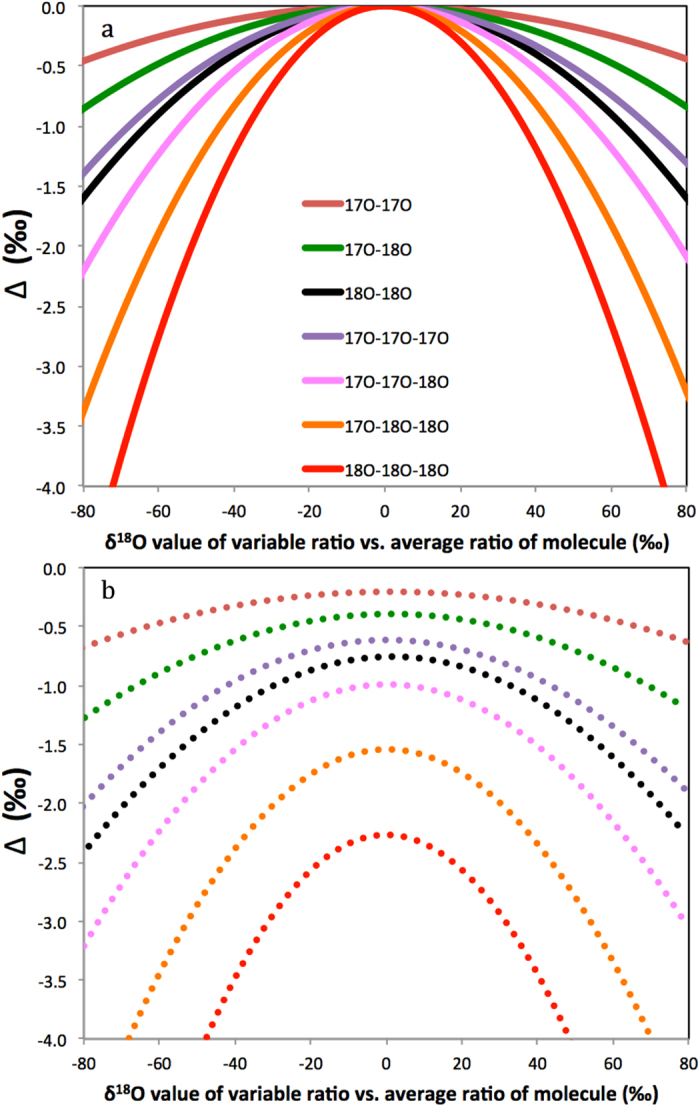
All combinations of 17O-18O heavy isotope clumping for three indistinguishable O atoms in O3 as function of the δ18O value of the variable isotope ratio versus the average isotope ratio in the molecule.The curves for clumping of a single isotope are the same as in Figures 2 and 3 (red and black curves refer to red solid curves in Figures 2 and 3, respectively). In all scenarios two isotope ratios are kept fixed and the third isotope ratio is varied. In (a) the two fixed isotope ratios are identical, which includes the situation that all isotope ratios are identical and Δ = 0‰, in (b) one of the fixed isotope ratios is 10% higher than the other. 17O and 18O ratios are linked via the mass dependent fractionation equation .